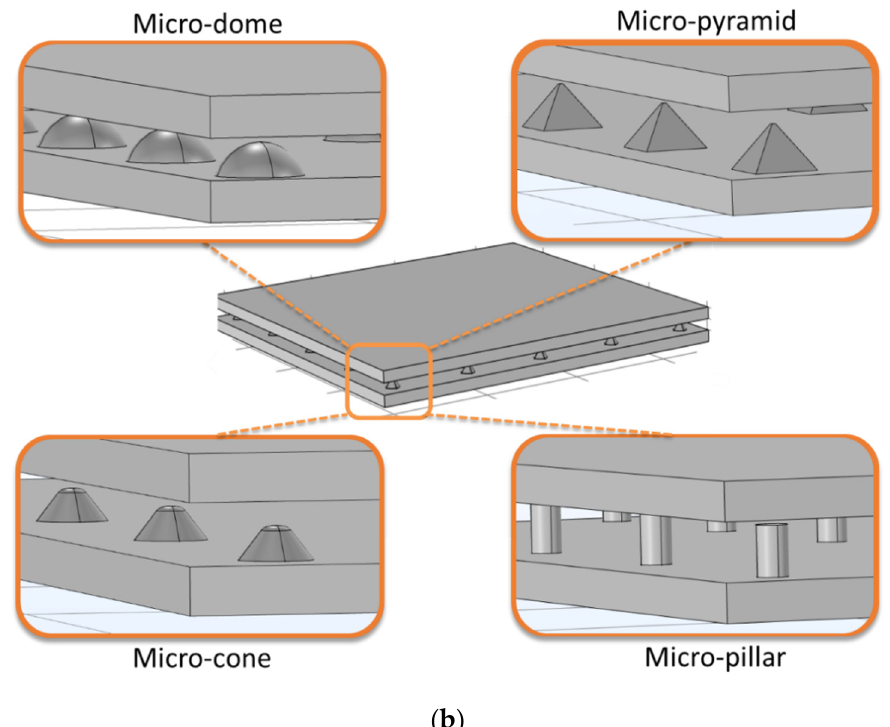
Figure 1. Piezo-resistive sensor. ( a ) Schematic of a micro-pyramid piezo-resistive sensor showing parameters such as pyramid angle “ α ” and pyramid base size “ ℓ ”. ( b ) Different proposed micro- feature shapes for a three dimensional 1.8 mm × 1.8 mm piezo-resistive sensor.